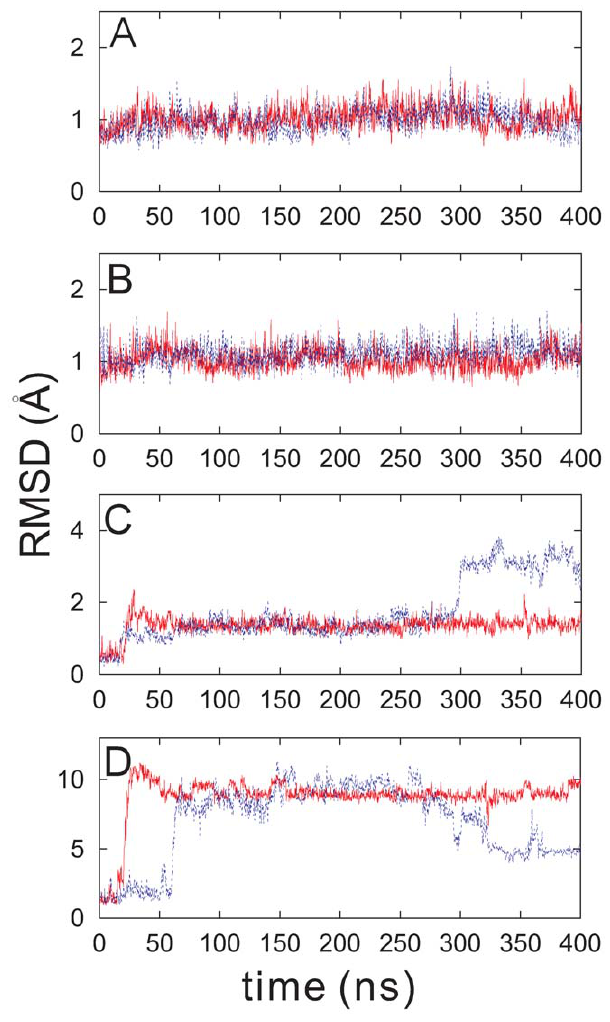
Figure 10. RMSDs for (A) PDC109/a, (B) PDC109/b, (C) linker, and (D) the entire protein. The time series for ligand-bound and free PDC109 is shown in blue and red, respectively.